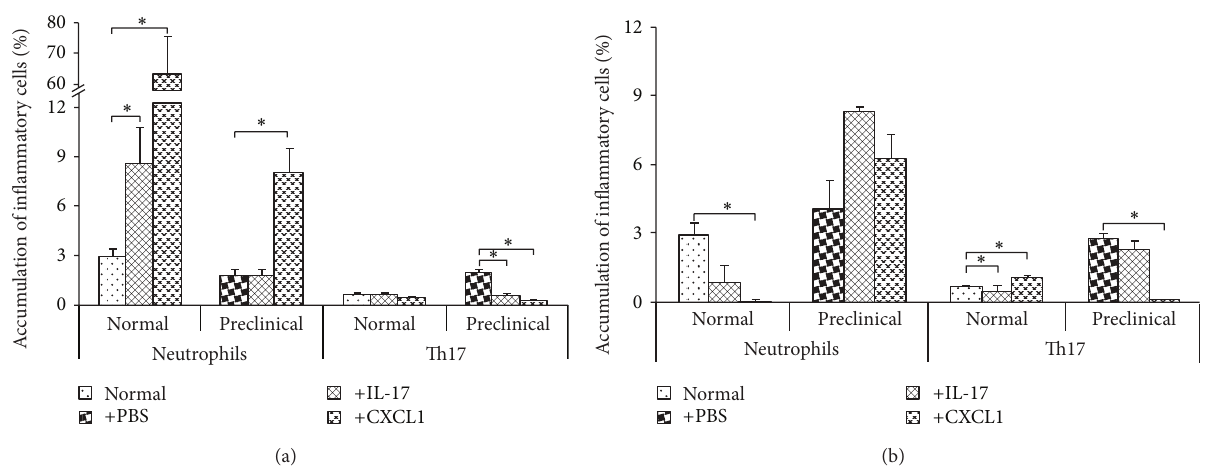
Figure 3: Accumulation of Th17 cells and neutrophils in the brain after stereotaxic intracerebral delivery of IL-17 or CXCL1. (a) 24 h after delivery, (b) 72 h after delivery. Accumulation of cells was measured in healthy control (Normal) mice and in immunized, preclinical mice by flow cytometry. Data are presented as mean ± SEM. ∗ 0.05 ≥ 𝑃 ≥ 0.01